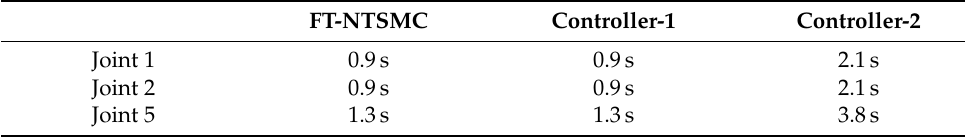
Table 4. The settling time of the unilateral active joints under the three